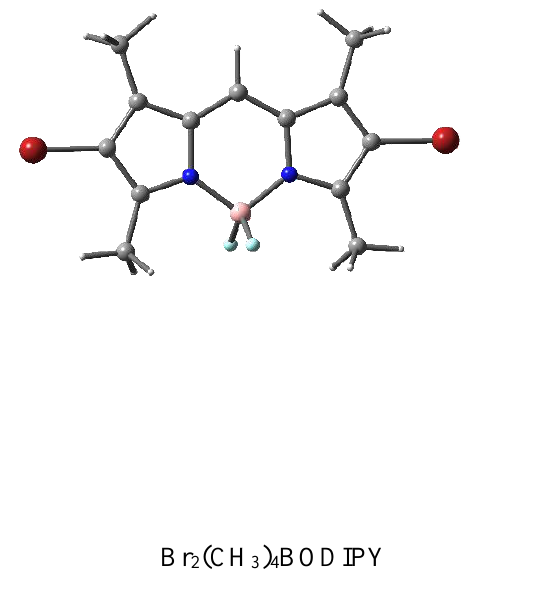
Figure 5. Structural formulas of dipyrromethene complexes, where the atoms are represented with the following colors: C (gray), N (blue), and H (white), halogenated with Br (red) and coordinated using both Zn and Cd (yellow) or B (pink), terminated by F (light blue).